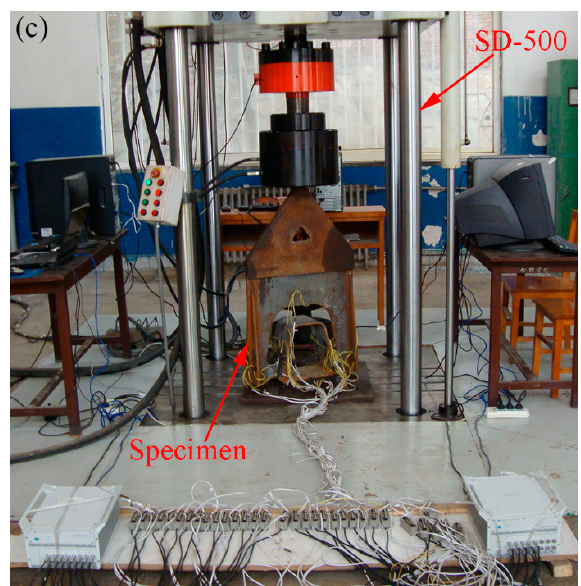
Figure 9. Schematic of the strain rosette location: ( a ) Strain gauges on the diaphragm, ( b ) Strain rosettes on the closed rib in A and B directions, respectively (in mm), ( c ) Photo of and the testing field and fatigue specimen.